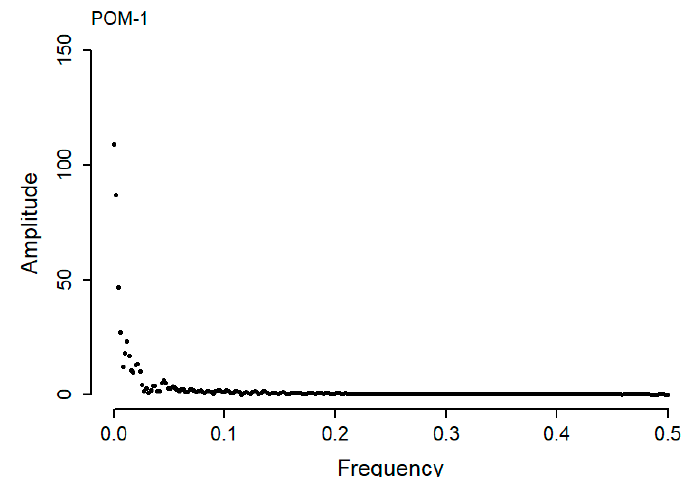
Figure 4. Fast Fourier transform, frequency domain plot of the time domain signal data shown in Table 2 for point-operating machine POM-1, moving in the NR direction.